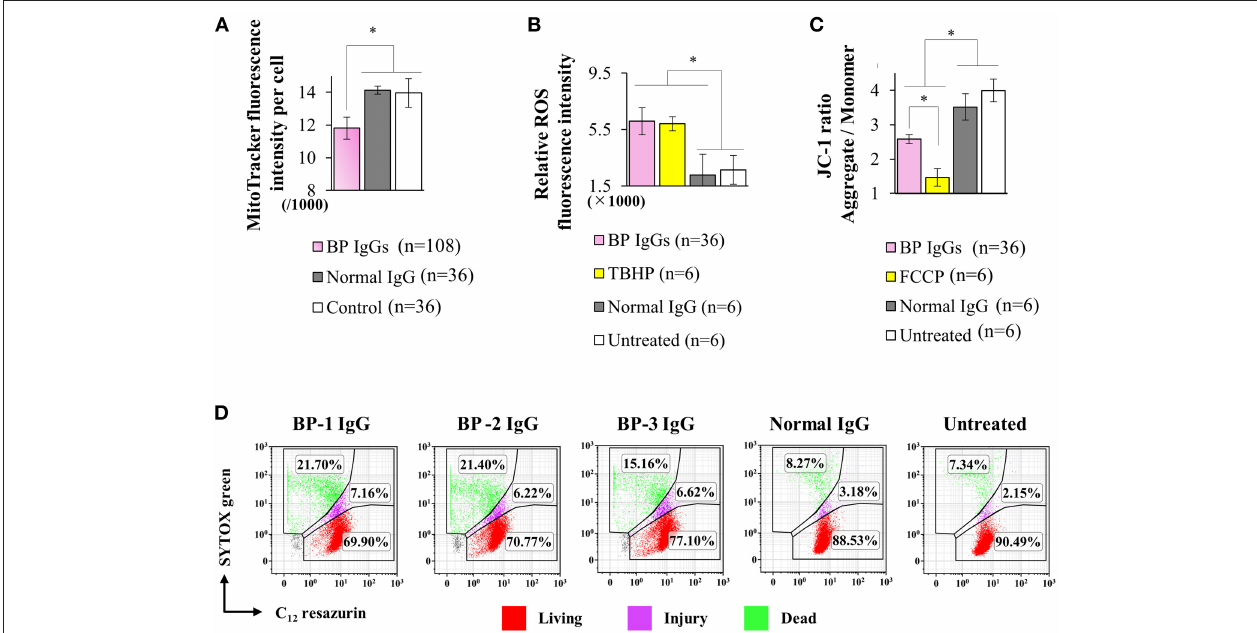
FIGURE 7 | Effects of BP IgG on mitochondrial function in NHEKs. (A) Mitochondrial staining intensities (MitoTracker ® Red CMXRos) were evaluated in NHEKs incubated with a pool of BP IgGs (from BP-1, BP-2, and BP-3) or normal IgG for 16h. One-way ANOVA was used for the statistical analysis. * p -value < 0.05. (B) ROS were detected in NHEKs stimulated with BP IgGs or normal IgG for 6h. TBHP was used as a positive control. One-way ANOVA was used for the statistical analysis. * p -value < 0.05. (C) The mitochondrial membrane potential was assayed in NHEKs treated with BP IgGs or normal IgG for 20h. FCCP was used as a positive control. One-way ANOVA was used for the statistical analysis. * p -value < 0.05. (D) NHEKs were collected after a 16h incubation with the indicated IgGs, then stained with SYTOX green (stains dead cells) and C 12 -resazurin (stains living cells), and subjected to flow cytometry.